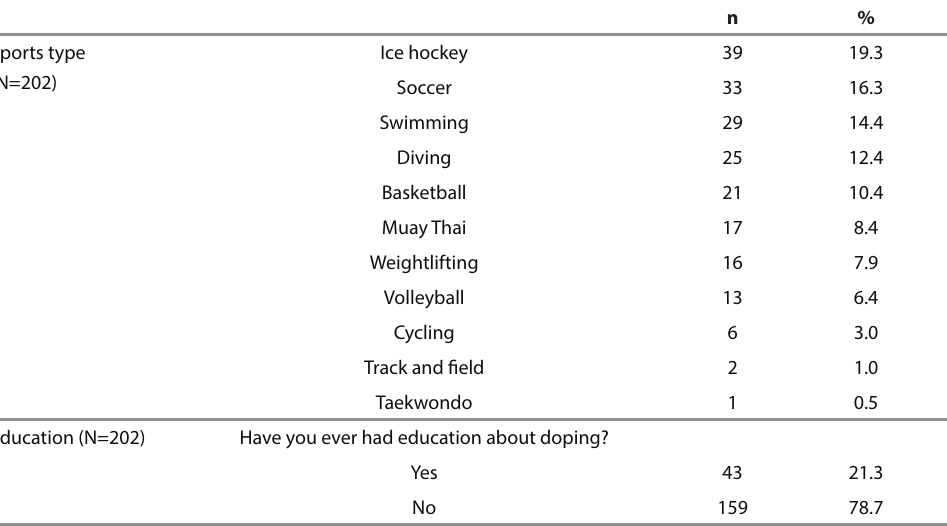
TABLE 1. Distribution of the athletes according to sport type and doping training status